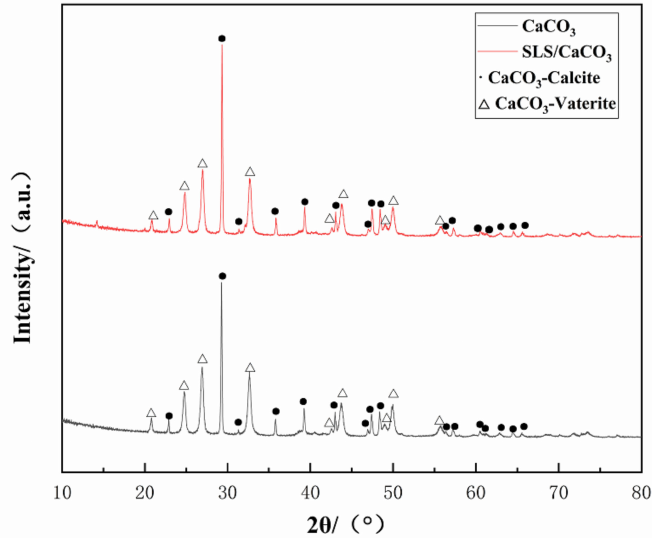
Figure 3. XRD spectrum of loaded and unloaded CaCO 3